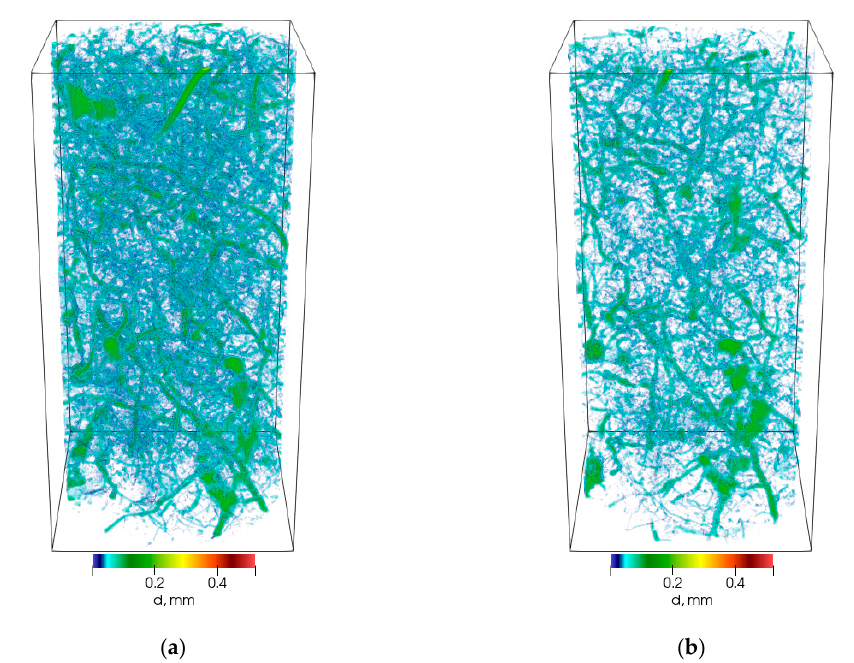
Figure 4. Void visualization of a sample which was taken from 80–90 cm depth from the B2 horizon (a) in a dry condition and (b) in a moisture-saturated condition. The Euclidean distance to the solid phase is illustrated in color. It can be observed that some small pores and channels present in the dry sample image on the left are absent from the wet sample image on the right. Large pores and channels were narrowed but present in the image of the wet sample.